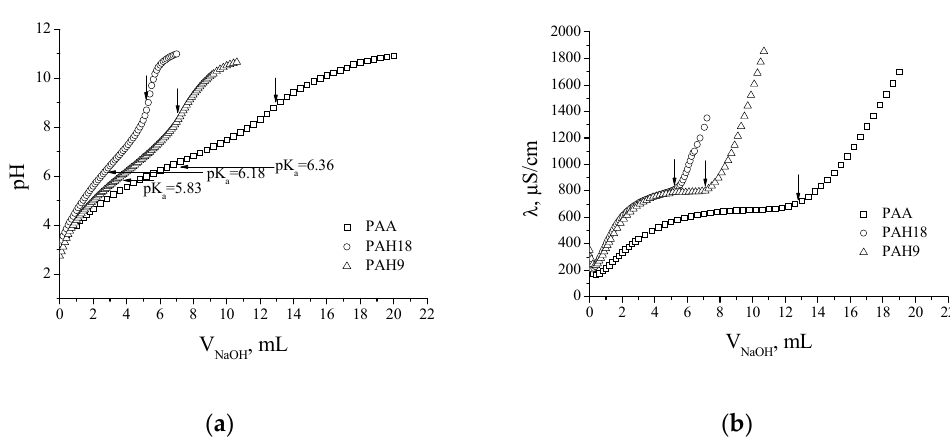
Figure 1. Curves of ( a ) pH and ( b ) conductometric titration for 0.25% polymer solutions.